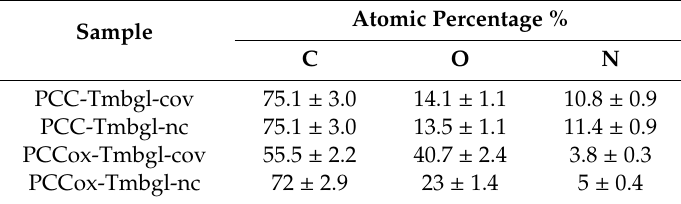
Table 2. Atomic percentages of PCC-Tmbgl-cov, PCC-Tmbgl-nc, PCCox-Tmbgl-cov, and PCCox-Tmbgl-nc.